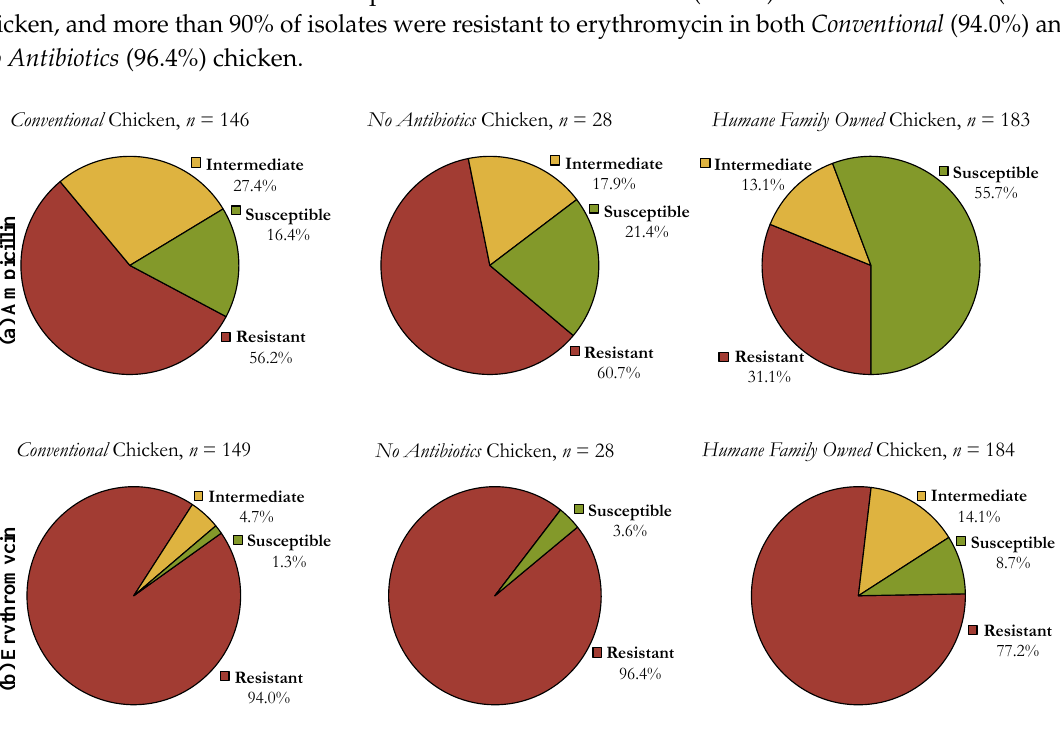
Figure 2. Each column per production grouping represents a unique retail broiler chicken option. Error bars represent 95% confidence intervals of the sampling distribution of the proportion of isolates susceptible. Error bars that would theoretically extend past zero were truncated. Statistical significance letters A and B shown on the graphs refer to whether the fraction of isolates susceptible are different between production groupings. Same letters show no significant difference, while different letters show a difference between groupings. The vertical orange line represents the mean fraction of susceptible E. coli isolates to ( a ) ampicillin and ( b ) erythromycin grouped by Conventional , No Antibiotics (NA) , and Humane Family Owned (HFO) .